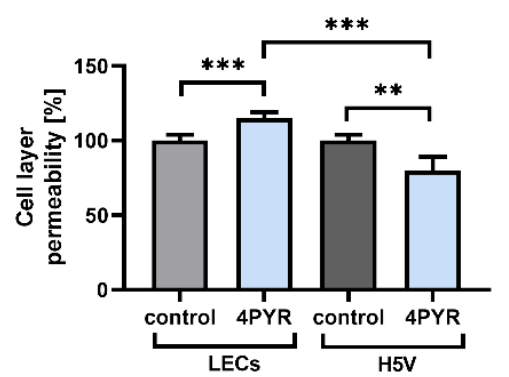
Figure 6. Divergent regulation of endothelial permeability by 4PYR. Effect of 4PYR on the permeabil- ity of LECs or H5V monolayers. Permeability was measured in a Transwell chamber (1 µ m pore size) as a flux of BSA-bound Evans blue dye 22 h after the addition of 100 µ M of 4PYR to the upper chamber containing ECs. Monolayer integrity was assessed using staining with Mayer’s Hematoxylin. Any inserts with cell detachment were discarded from the data set. The graph represents the mean ± SEM from four independent experiments. ** p < 0.01, *** p < 0.001 vs. control (non-treated cells).